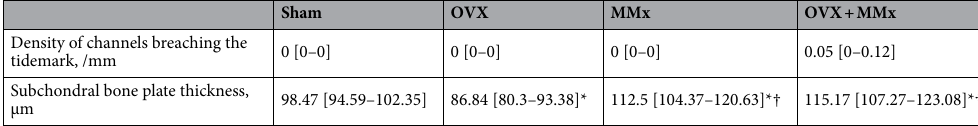
Table 2. Density of channels breaching the tidemark and subchondral bone plate thickness. Values are presented as the means and 95% CIs. *: p < 0.05 compared with the Sham group; †: p < 0.05 compared with the OVX